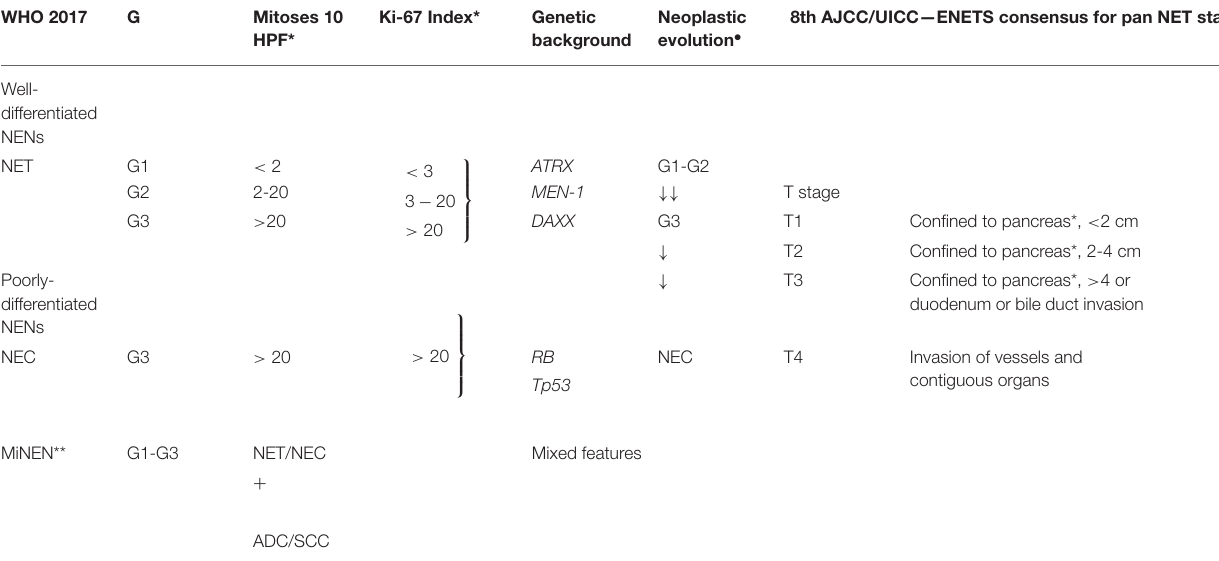
TABLE 1 | Current WHO grading guidelines and 8th AJCC/UICC—ENETS consensus for pancreatic neuroendocrine neoplasms (11, 12). WHO